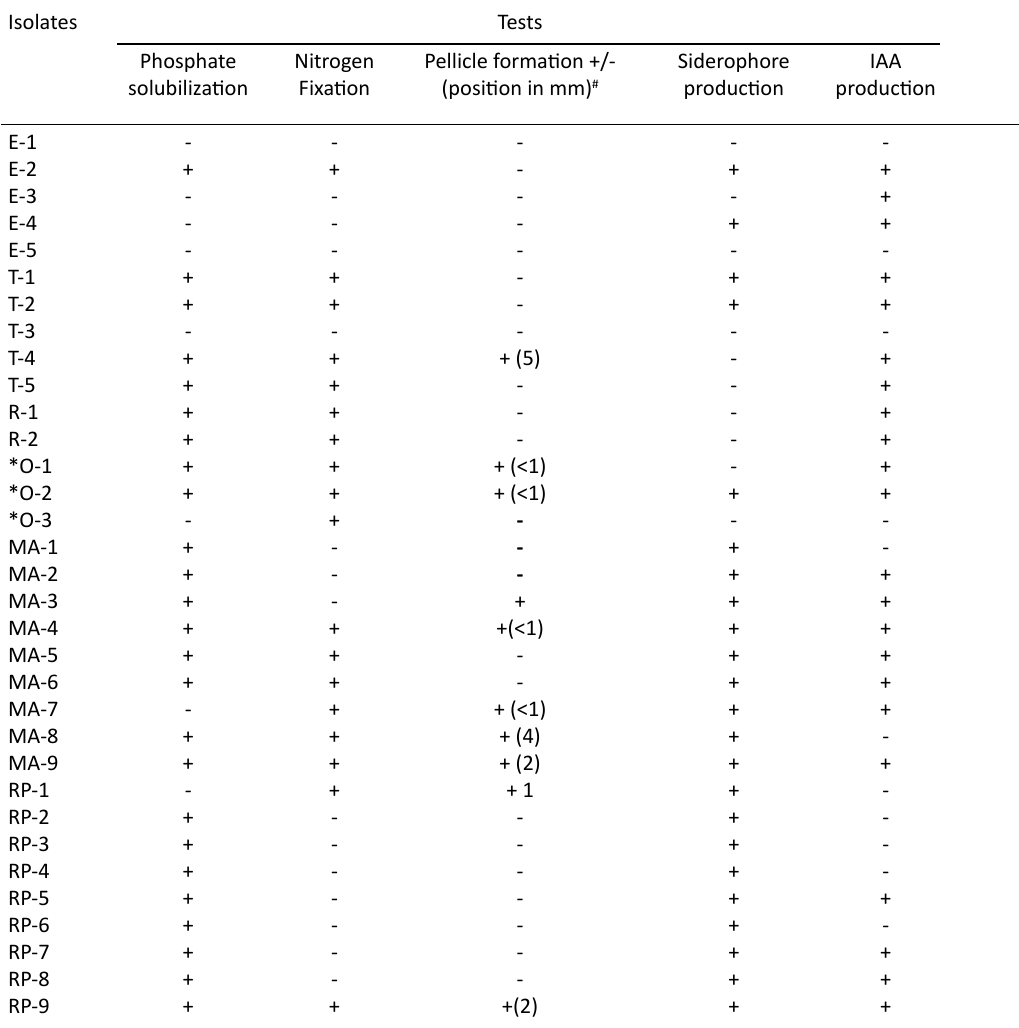
table 3. In-vitro plant growth promoting activity of isolates Isolates Tests Pellicle formation